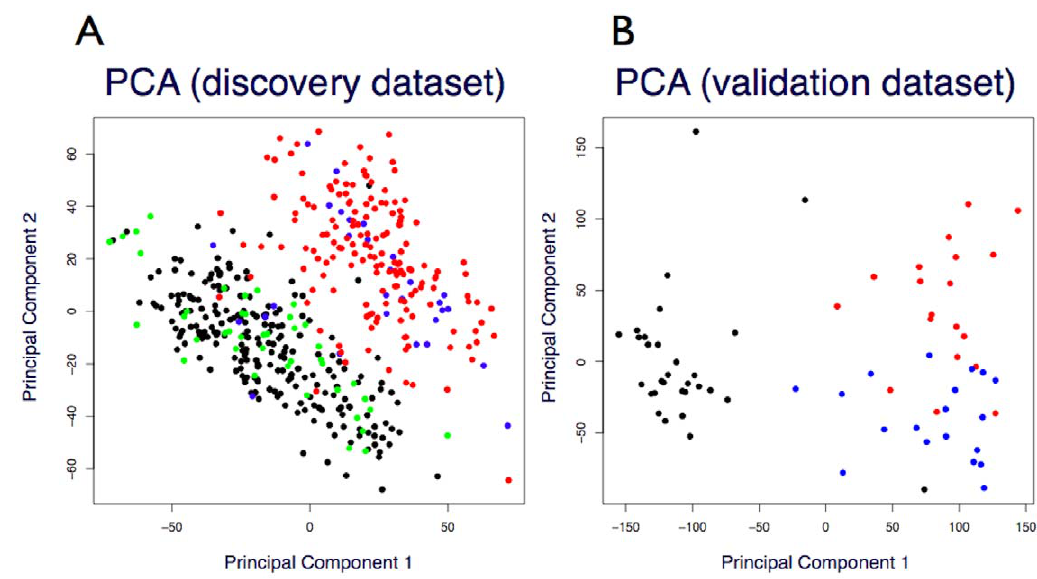
Figure 1. Principal component analysis of microarray gene expression profiles. (A) Discovery microarray dataset: 222 normal, black; 42 colitis/IBD, green; 29 adenomas, blue; and 161 adenocarcinomas, red. (B) Validation microarray dataset: 30 normal, black; 19 adenomas, blue; and 19